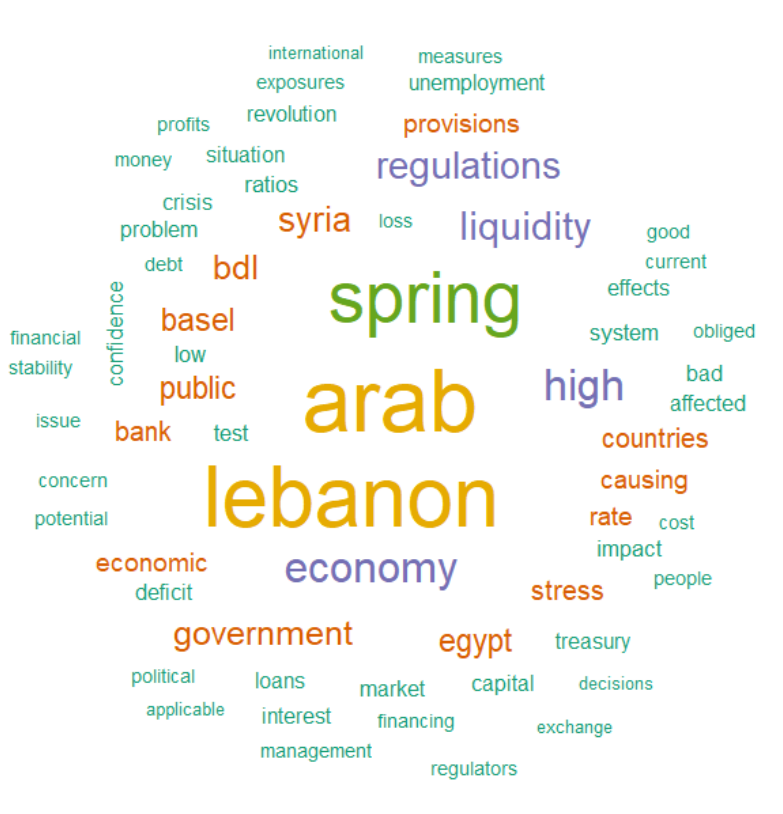
Figure 7. Interview data word